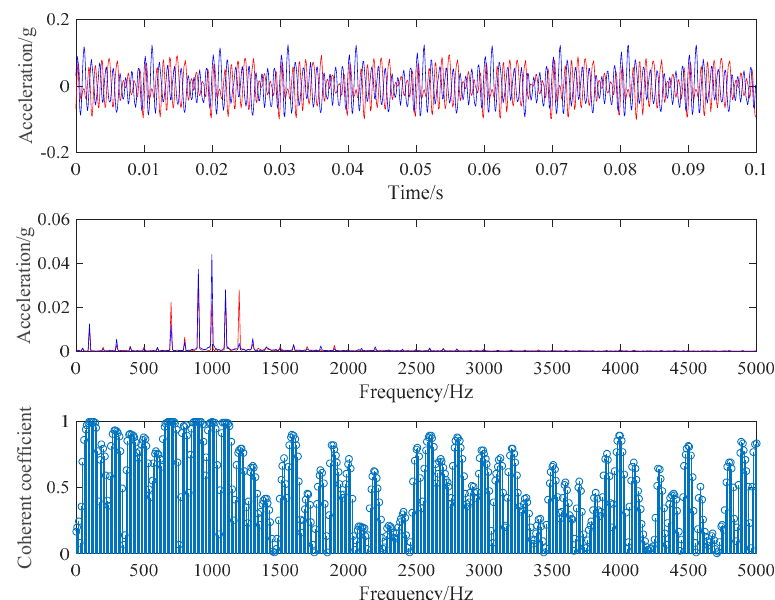
Figure 4. Comparison of coherent results.